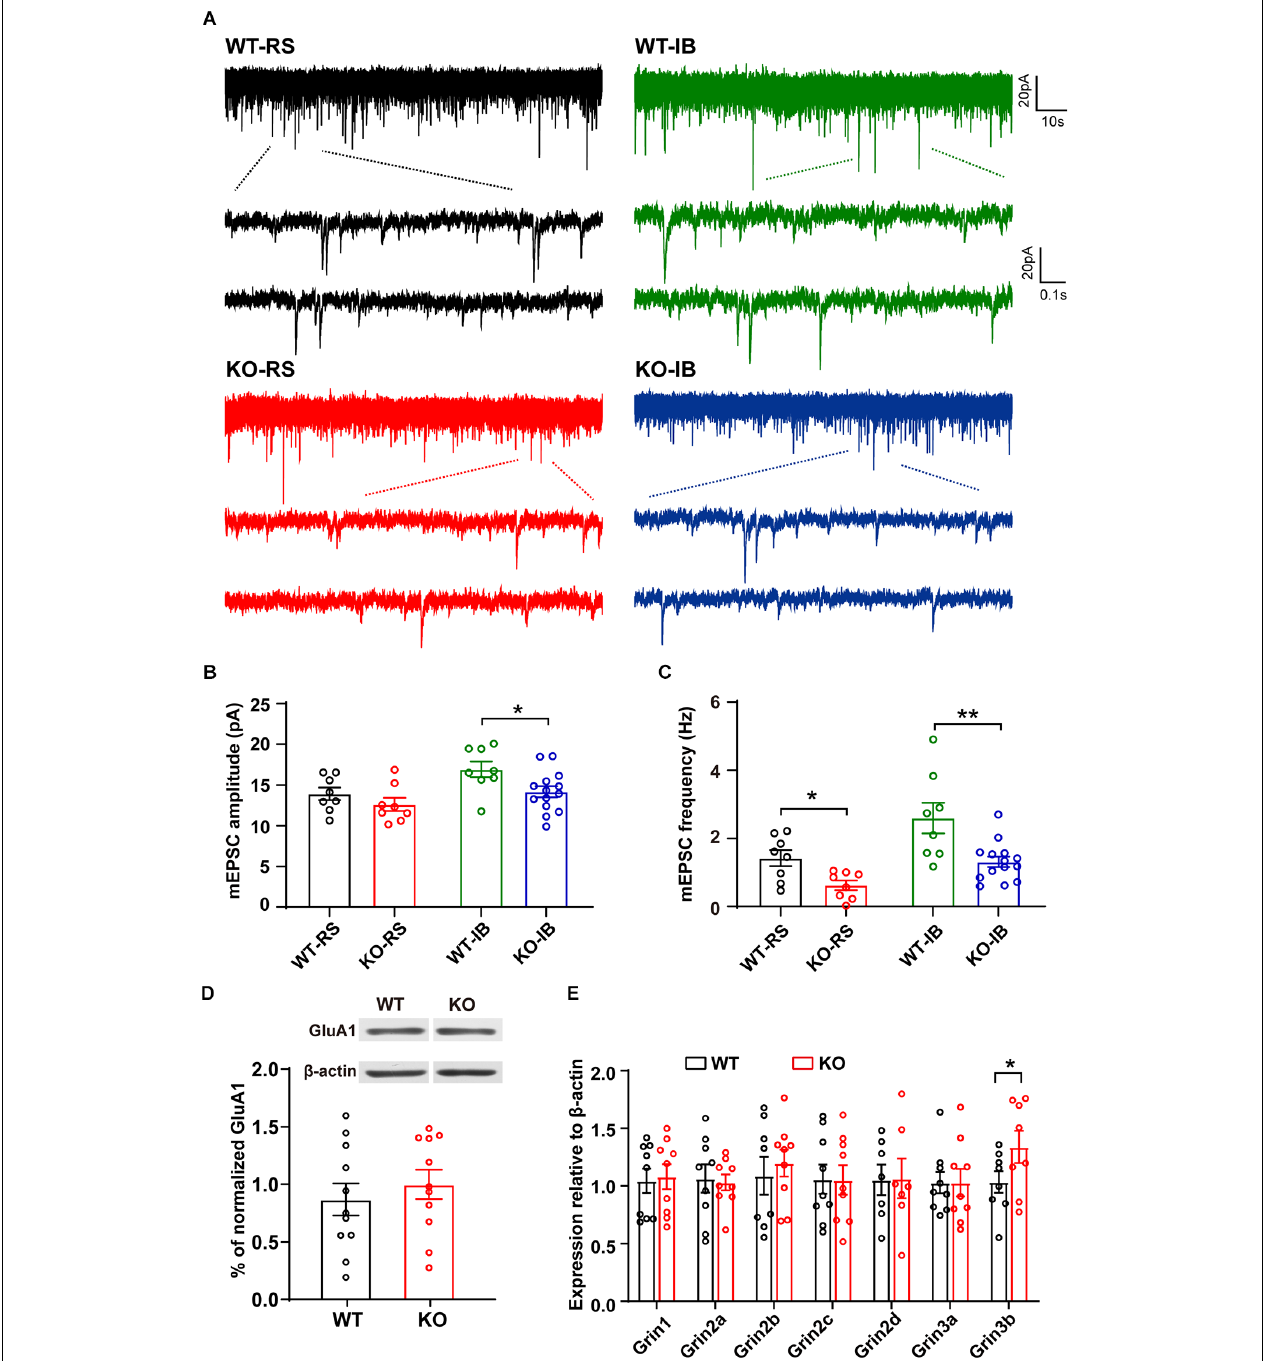
FIGURE 3 | Spontaneous glutamatergic synaptic transmission in L5 pyramidal neurons of WT and KO mice. (A) Representative recordings of mEPSCs and two consecutive traces are shown below in an expanded time scale. (B) Quantification of mEPSC amplitude (WT-RS vs. KO-RS, t (14) = 1.167, p = 0.2627; WT-IB vs. KO-IB, t (20) = 2.410, p = 0.0257; unpaired t -test). (C) Quantification of mEPSC frequency (WT-RS vs. KO-RS, t (14) = 2.938, p = 0.0108; WT-IB vs. KO-IB, t (20) = 3.281, p = 0.0037; unpaired t -test). (D) Representative Western blot and the quantitative analysis of GluA1 protein (WT vs. KO, t (20) = 0.6931, p = 0.4962; unpaired t -test). (E) Expression of Grin1-Grin3b mRNA (WT-Grin1 vs. KO-Grin1, t (16) = 0.238, p = 0.8151; WT-Grin2a vs. KO-Grin2a, t (16) = 0.237, p = 0.8160; WT-Grin2b vs. KO-Grin2b, t (15) = 0.554, p = 0.5878; WT-Grin2c vs. KO-Grin2c, t (16) = 0.040, p = 0.9689; WT-Grin2d vs. KO-Grin2d, t (12) = 0.052, p = 0.9594; WT-Grin3a vs. KO-Grin3a, t (16) = 0.006, p = 0.9951; WT-Grin3b vs. KO-Grin3b, t (14) = 1.802, p = 0.0329; unpaired t -test). (B,C) Results from RS (WT, n = 8; KO, n = 8) and IB (WT, n = 8; KO, n = 14) cells from WT ( N = 7 mice) and KO mice ( N = 8 mice). (D) p53KO ( N = 11) and WT ( N = 11) mice. (E) p53KO ( N = 7–9) and WT ( N = 7–9) mice. * p < 0.05; ** p < 0.01.